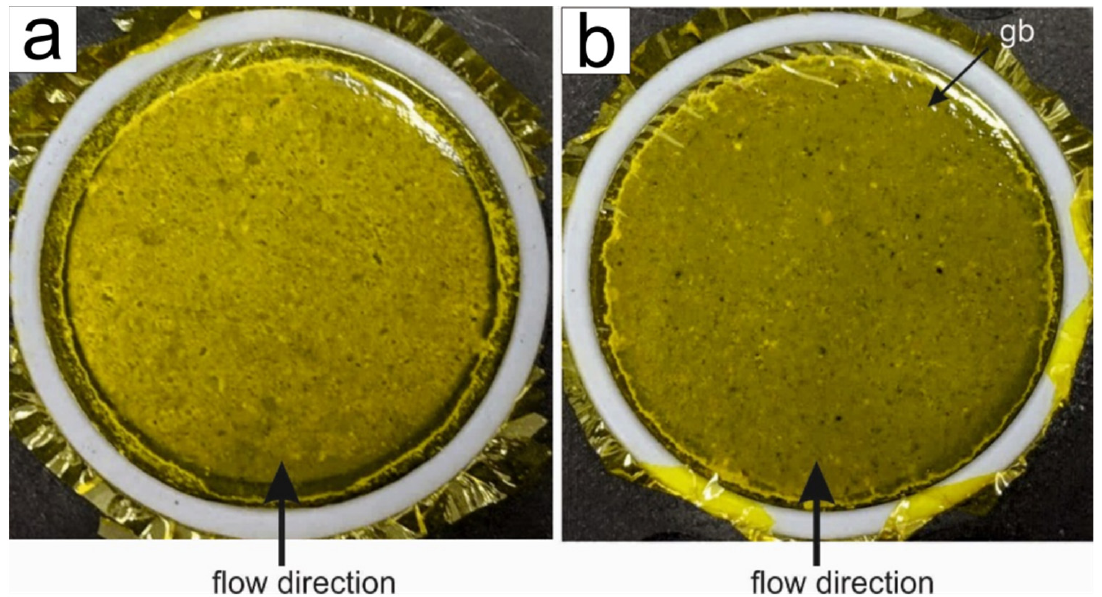
Figure 3. Photographs of the well cell experiments of hydrated SD80 bentonite close to the steady-state condition ( a ) infiltrated by Opalinus clay pore water and ( b ) infiltrated by diluted cap rock brine. gb = gas bubbles.